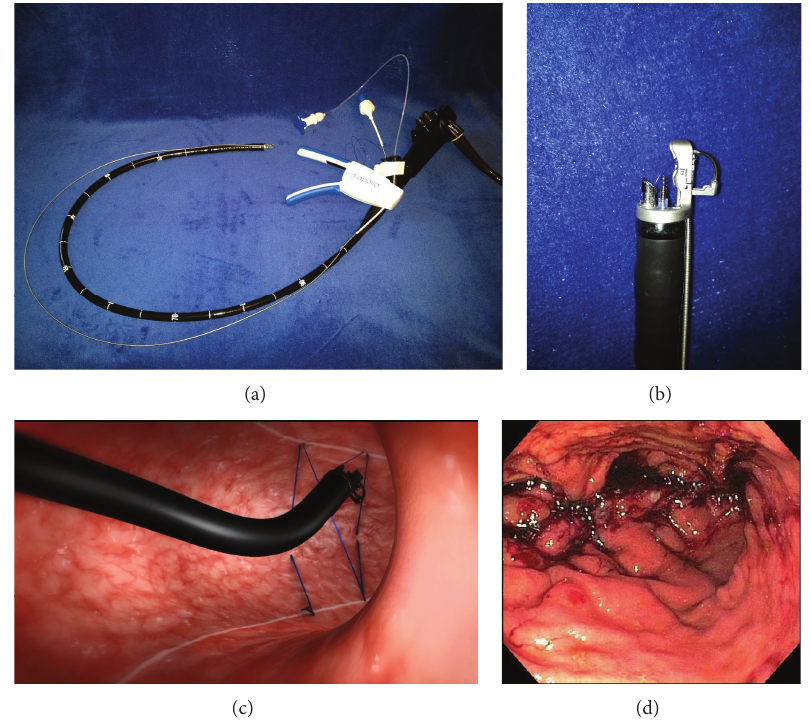
Figure 2: Ex vivo image of the commercially available full thickness suturing system (Overstitch; Apollo Endosurgery, Austin, TX). (a) Image of the device mounted on a double channel gastroscope. (b) A close-up view of the suture mechanism on the tip of the gastroscope. (c) Animation of an efficient suture pattern now performed for endoscopic gastric volume reduction. (d) Endoscopic view of the stomach after the 1st layer of